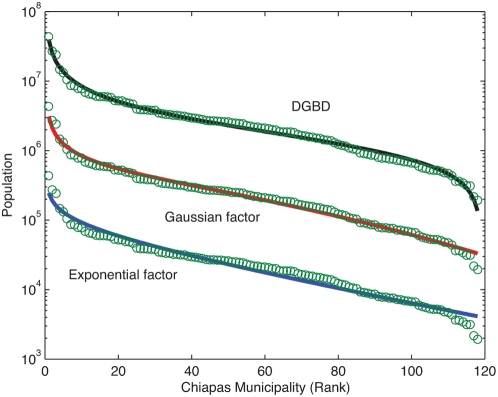
Two parameter fits for rank ordered data.The figure shows three fits for the population of the municipalities of the Mexican state of Chiapas [26] plotted in decreasing order. The bottom set of points corresponds to the original data, the other two sets have been obtained by successively multiplying by 10 in order to distinguish the behavior of the each fit. The top fit is the DGDB distribution, the middle one corresponds to a power law multiplied by a Gaussian factor and the bottom is a power law multiplied by an exponential factor. All fits have two adjustable parameters and produce good values for R2, in the neighbourhood of 0.97. Notice however that the DGBD curve reproduces more successfully the overall form of the data, particularly at the two extremes.